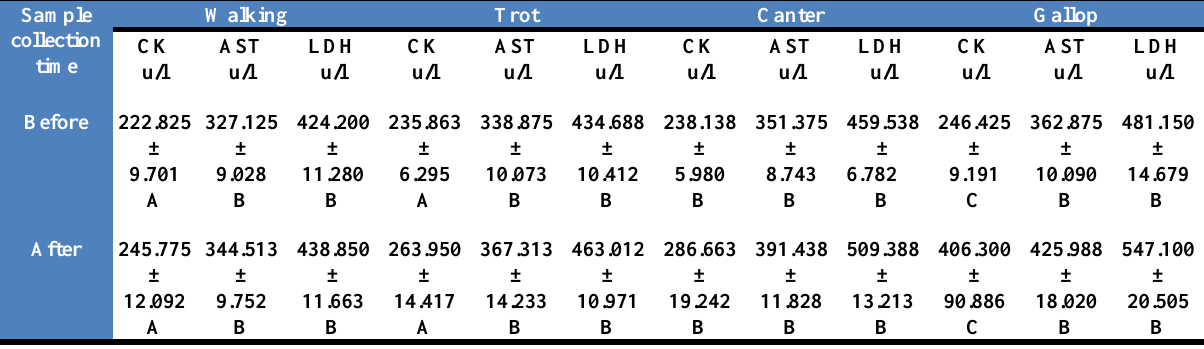
Table, 4: The mean values ± SE of biochemical parameters of synovial fluid (CK, AST and LDH) at different speeds.